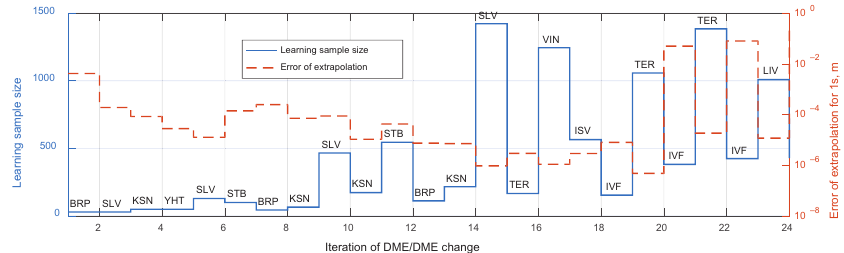
Figure 5. Learning sample size and extrapolation error value at each stage of distance prediction